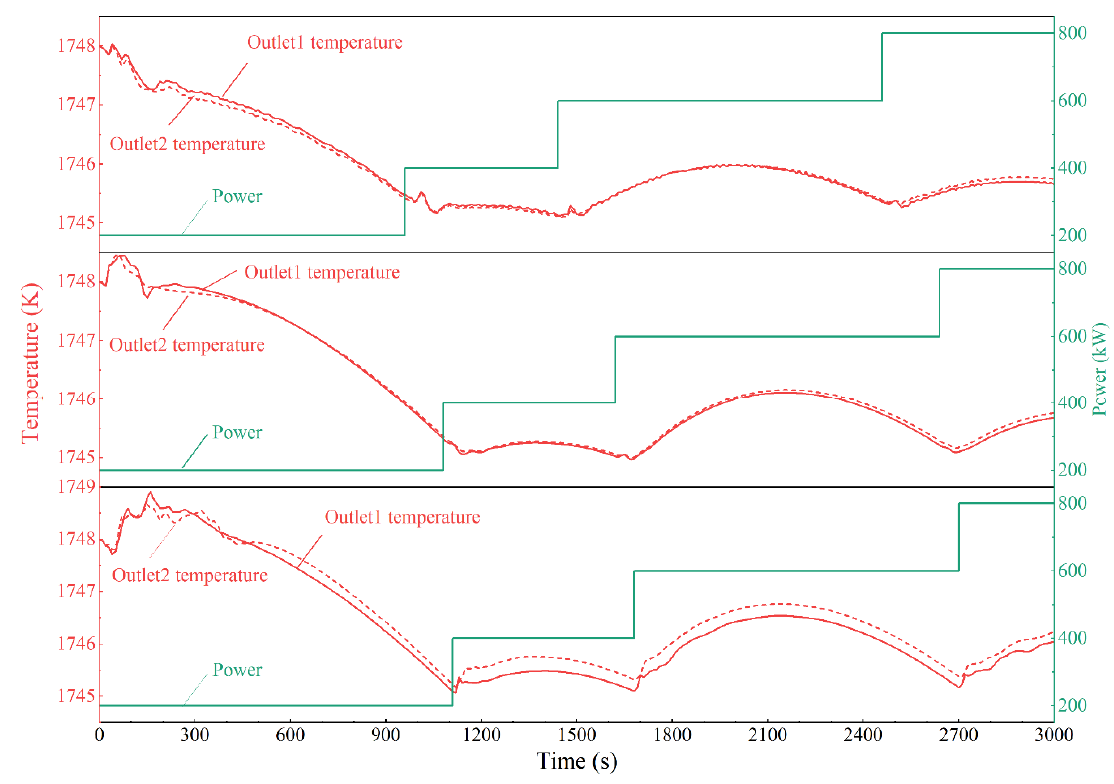
Figure 14. Power curve and variation of casting temperature in tundishes. From top to bottom, tundishes A, B, and C are depicted in sequence. Red solid line and red dash line represent molten steel temperature at outlet 1 and outlet 2, respectively. Green solid line represent power curve.